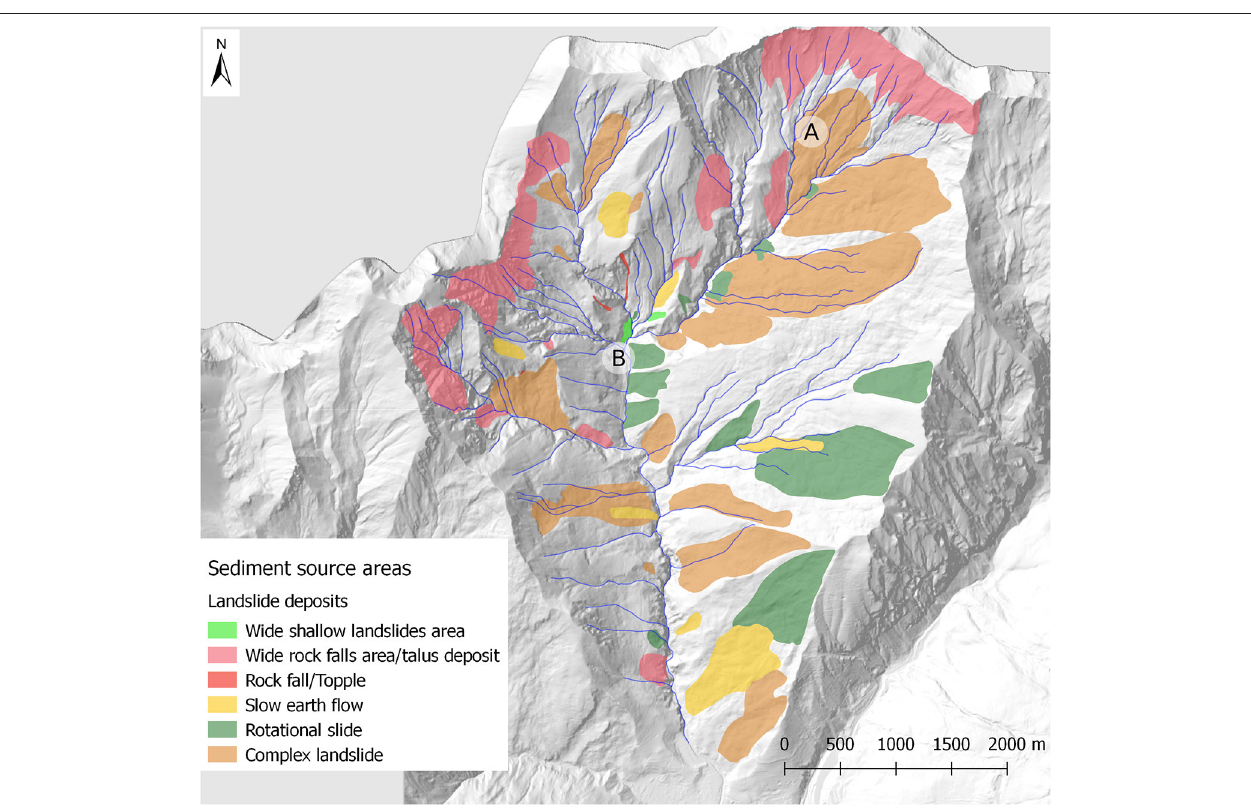
FIGURE 5 | Distribution of sediment source areas within the Rio Frejus catchment. A and B represent the location of example deposits shown in Figure 7 .